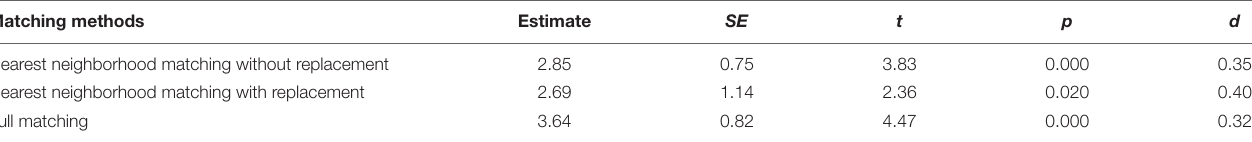
TABLE 8 | The average treatment effects on the treated individuals (ATTs) of the extensive reading for different matching methods. Matching methods